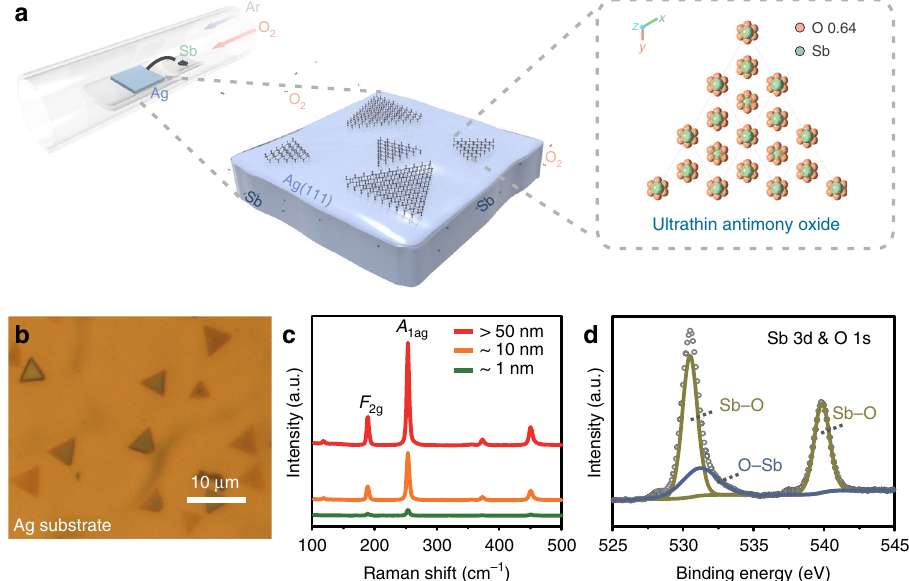
Fig. 1 Growth and spectral characterizations of ultrathin antimony oxide crystals. a Schematic of the strategy for the growth of ultrathin antimony oxide. b OM image of ultrathin antimony oxide crystals grown on the re-solidi fi ed Ag substrate. c Raman spectra of ultrathin antimony oxide crystals with different thicknesses. d XPS spectra of the ultrathin antimony